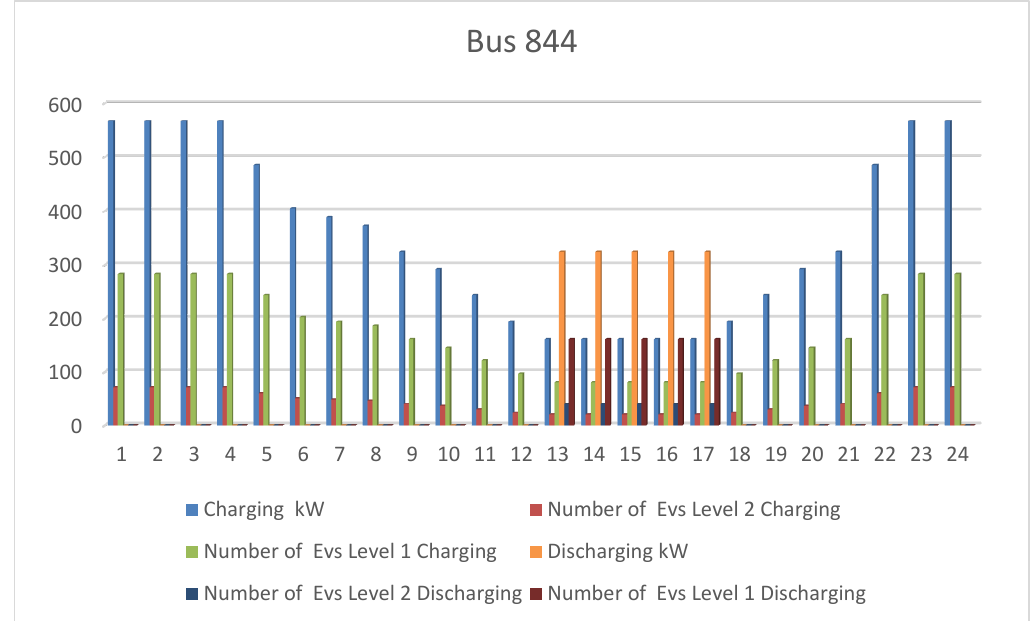
Figure 13 . Case 4 Additional Charging/Discharging Load and Number of EVs on Bus 860. Figure 13. Case 4 Additional Charging/Discharging Load and Number of EVs on Bus 860. Designs 2018 , 2 , x FOR PEER REVIEW